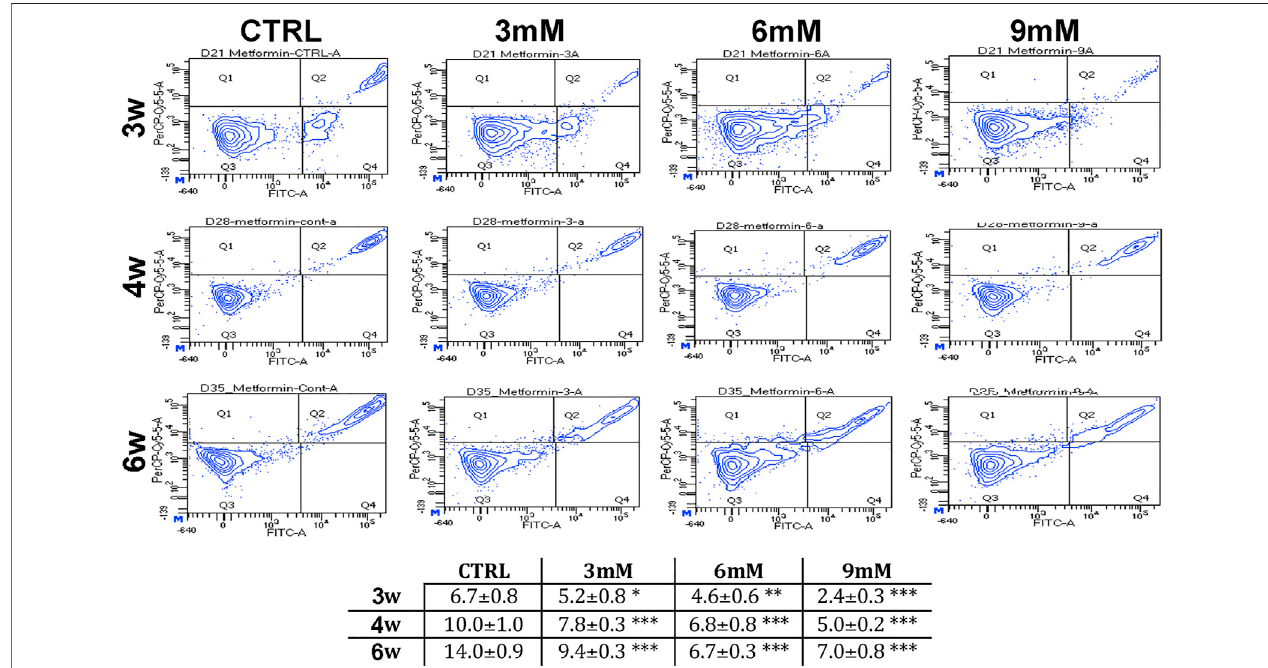
FIGURE 2 | Apoptosis levels in MSCs cultures. This table shows the percentage of apoptotic cells after three, four and 6 weeks of in vitro culture, either in the absence (CTRL) or presence of metformin. Data are shown with standard deviation (SD) n (cid:1) 3 * p < 0.05, ** p < 0.01, *** p < 0.001. For each time point, the symbol (*) indicatesthestatisticaldifferencebetweenthecontrolcultureandthosetreatedwithmetformin.Thepicturesshowrepresentativeimagesofannexin-Vdetectionby fl ow cytometry analysis. Apoptotic and non-apoptotic cells were identi fi ed by two separate dyes (Annexin V and 7AAD, respectively). The phosphatidylserine is bound byAnnexin V(FITC-A labeled)on theexternal membraneofapoptotic cells,while7AAD (PerCP-Cy5-5-Alabeled) permeates and stains DNAinlate-stageapoptotic and dead cells. Coloration enablestheidenti fi cation ofthree cellpopulations:non-apoptoticcells(AnnexinV-and 7AAD+);early apoptotic cells(annexinV+and 7AAD-);and late apoptotic or dead cells (Annexin V+ and 7AAD+). In our experimental conditions, both the early apoptotic and late apoptotic cells were grouped.